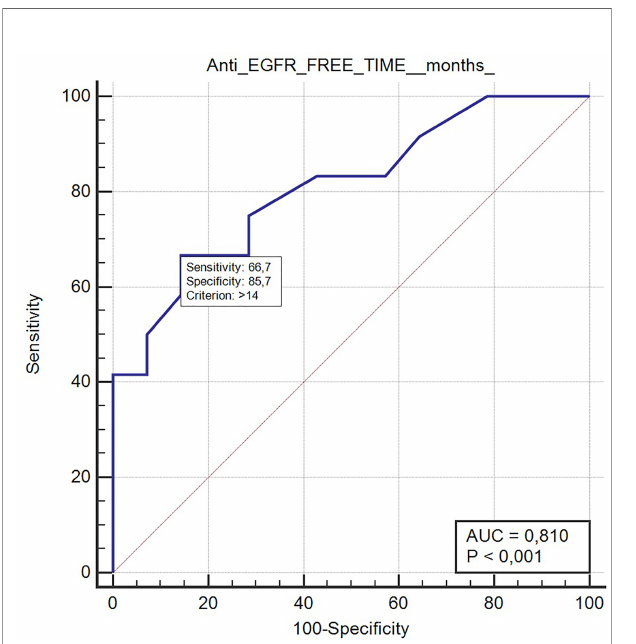
FIGURE 2 | ROC curve of anti-EGFR free-time predictive of response with rechallenge treatment (AUC 0.852; p <